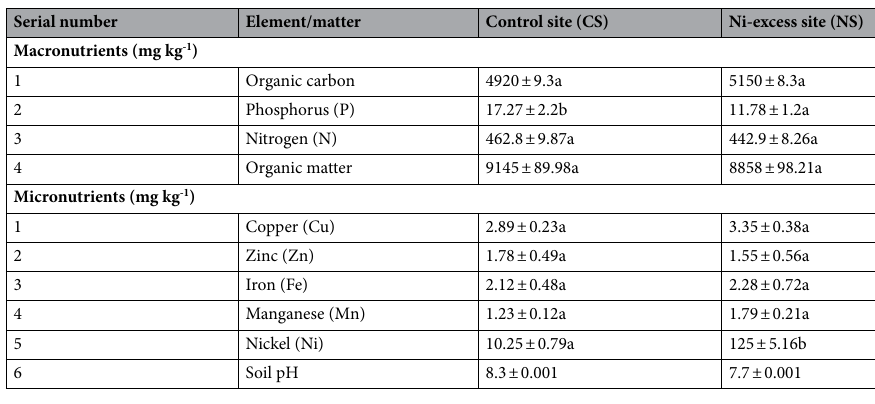
Table 1. Soil analyses of sites inhabited by Asterella wallichiana and Plagiochasma appendiculatum . Concentrations (mg kg -1 ) of macronutrients (organic carbon, phosphorus, nitrogen and organic matter), micronutrients (copper, zinc, iron and manganese) and trace elements (nickel, Ni) present in soil inhabited by A. wallichiana and P. appendiculatum under field conditions. Samples from five collection sites were individually taken. Sites with lower Ni concentrations (10.25 ± 0.79 mg kg -1 ) were referred as ‘control site’ (CS, n = 5) and sites with higher Ni concentrations (125 ± 5.16 mg kg -1 ) were referred as ‘Ni-excess site’ (NS, n = 5). Data presented are means ± standard errors. Different letters (a, b) within a row indicate significant differences from each other (Tukey’s test, P ≤